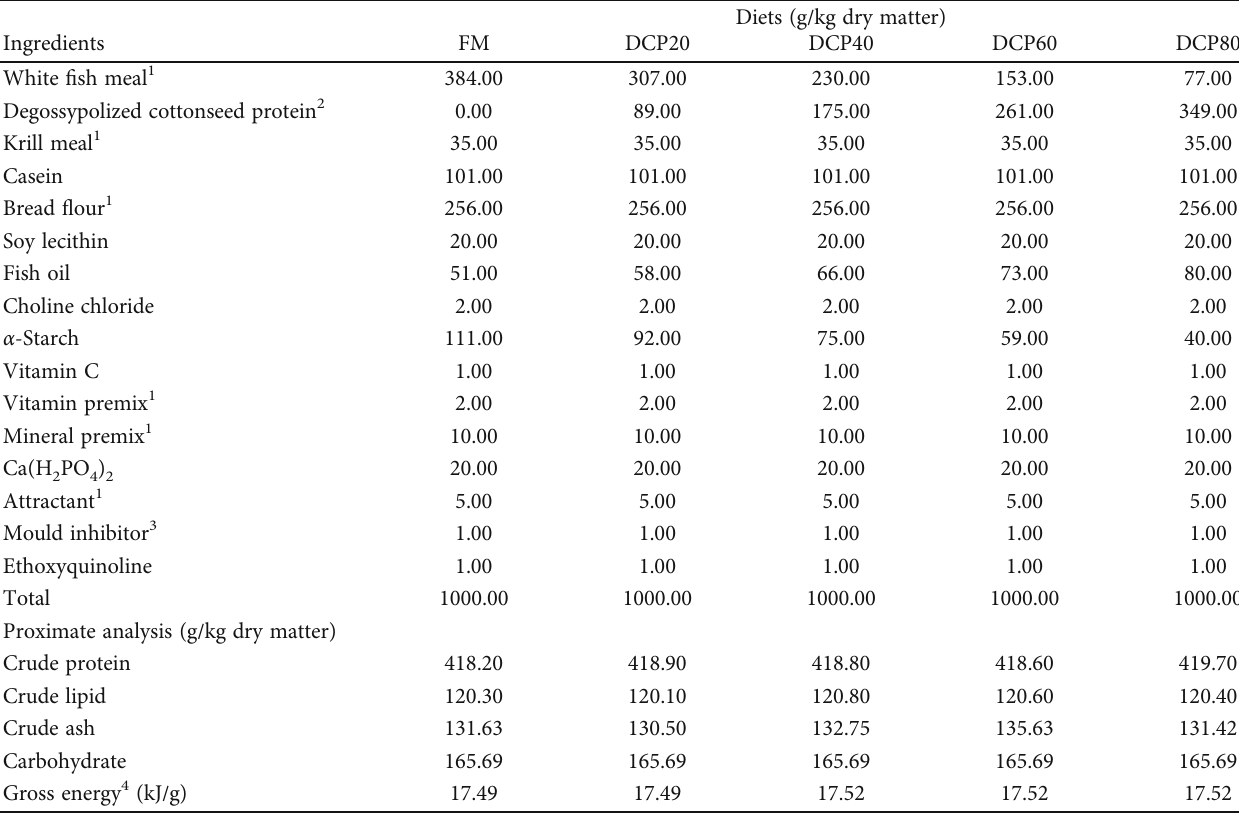
Table 1: Formulation and approximate composition of the experimental